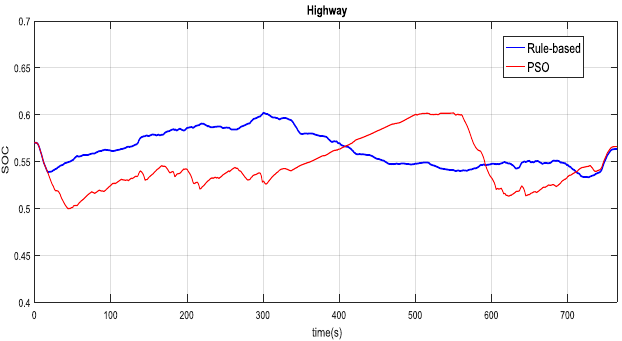
Figure 24. Battery SOC in the urban driving cycle.